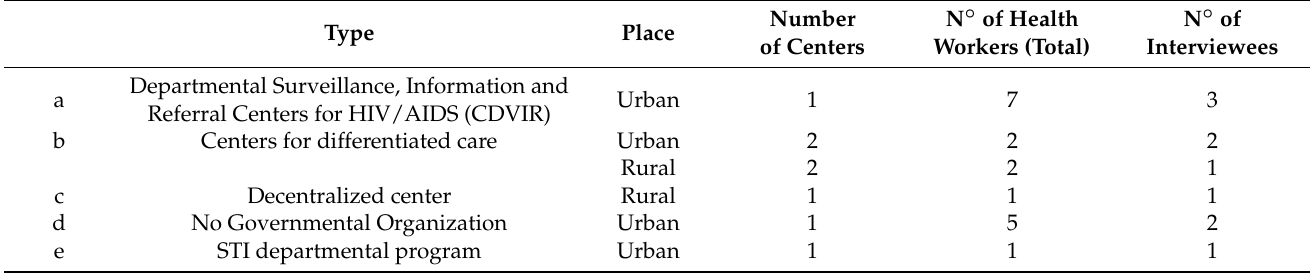
Table 1. Characteristics of Health Services that attend PLWHA in this study. Type Place